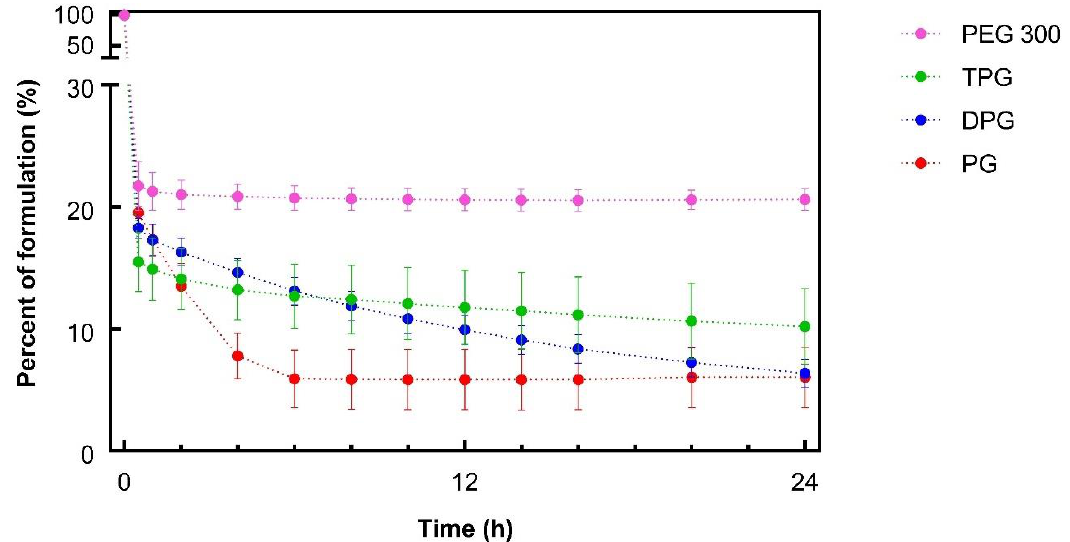
Figure 1. Percentage weight remaining for ibuprofen (IBU) formulations over 24 h under controlled conditions, 32 ± 1 °C and 50 ± 2% RH (mean ± SD; n = 3).